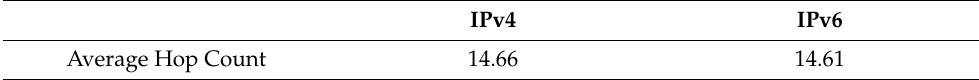
Table 4. Average hop count for